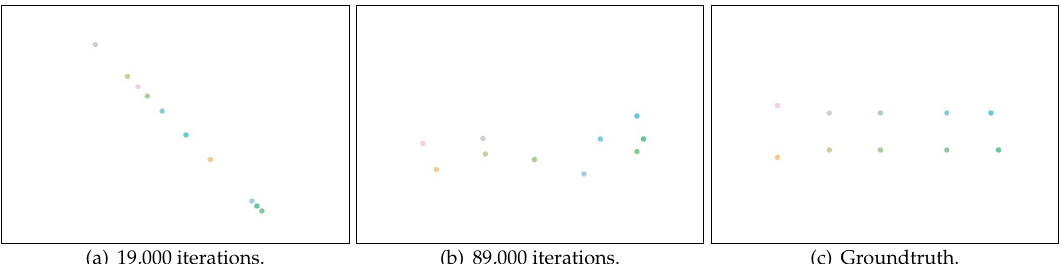
Figure 5. Stopping strategy: ( a ) learned locations with stopping strategy (after the first fluctuation); ( b ) the final result, which is the learned locations with stopping strategy (after the second fluctuation); ( c ) the ground truth.